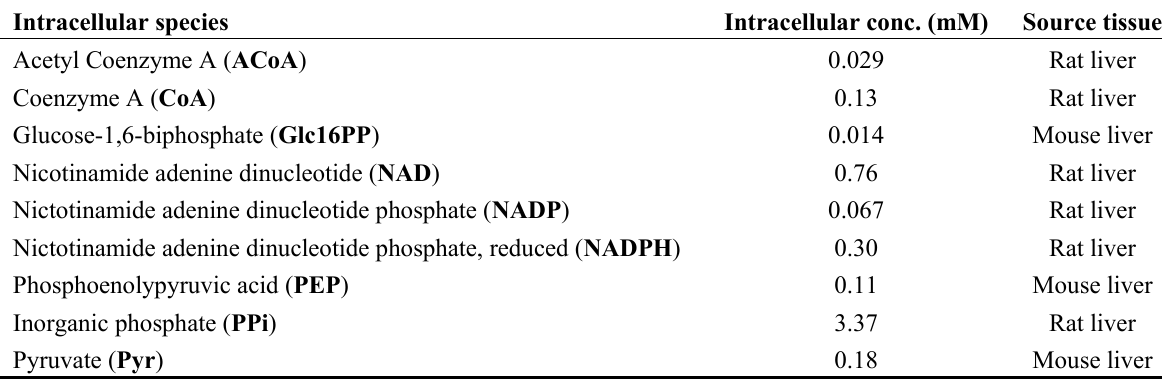
Table A7. Non-nucleotide sugar species and their intracellular